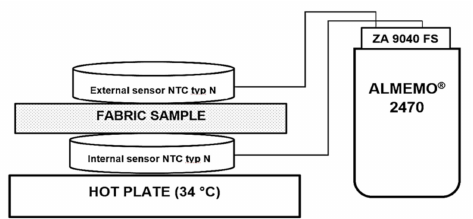
Figure 3. Principal measuring scheme of the external (1) and internal (2) thermocouple sensor equipment on the hot